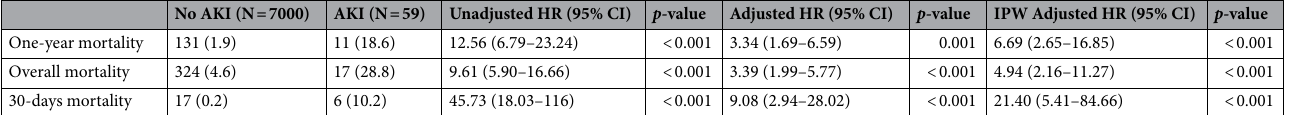
Table 2. Mortalities according to postoperative acute kidney injury (AKI). IPW inverse probability weighting, HR hazrd ratio, CI confidence interval. Multivariable analysis retained age, male, hypertension, Charlson comorbidity index, preoperative creatinine and hemoglobin levels, operative duration, general anesthesia, emergency operation, and type of surgery. IPW adjustment analysis retained age, male, hypertension, smoking, alcohol, Charlson comorbidity index, preoperative creatinine and hemoglobin levels, operative duration, general anesthesia, emergency operation, and type of surgery, and variables with absolute standard mean difference over 10% were further adjusted with regression